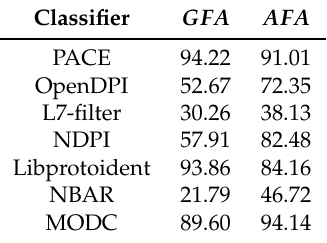
Table 7. Results for Global Flow Accuracy ( GFA ) and Average Flow Accuracy ( AFA